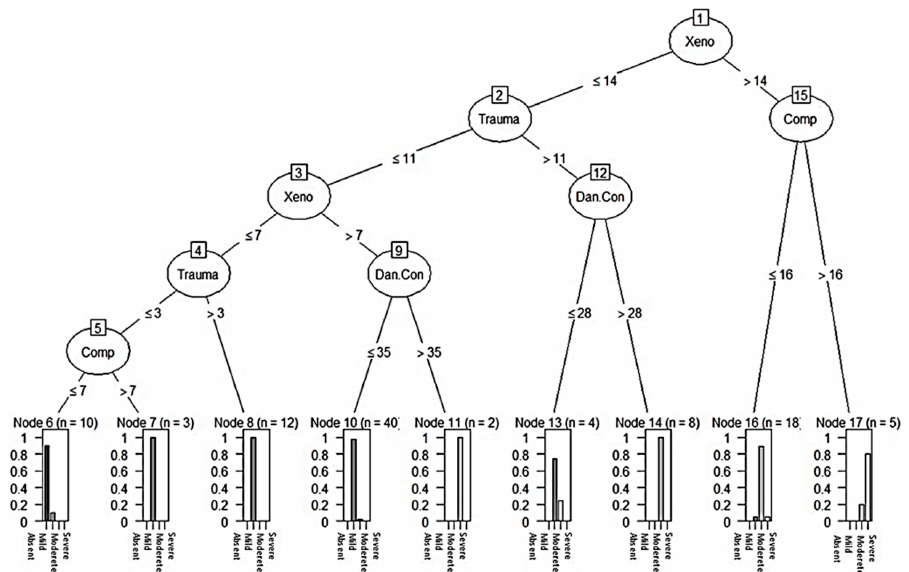
Table 4. Confusion matrix of obtained decision tree model for stress level classification .